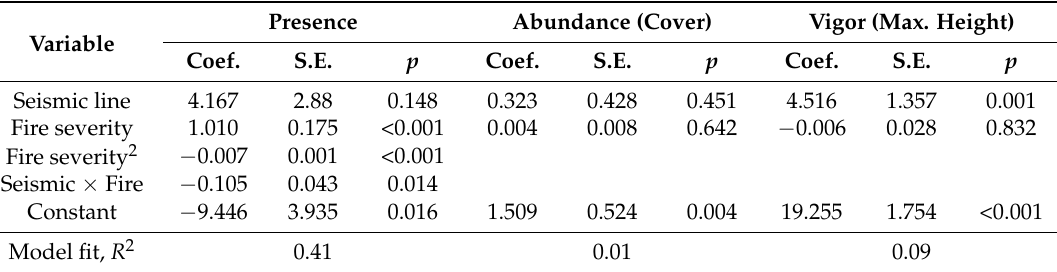
Table 1. Mixed effect regression results relating the presence, abundance (cover), and vigor (maximum height) of Vaccinium myrtilloides plants as a function of location (seismic line versus adjacent forest), fire severity, and the interaction of fire severity (% tree mortality) and location. Model coefficients (Coef.), Standard Error (S.E.) of coefficients, and significance ( p ) reported. Main treatment variables were retained regardless of significance, while a non-linear effect for fire severity and interaction term between fire severity and seismic lines were included only if significant.